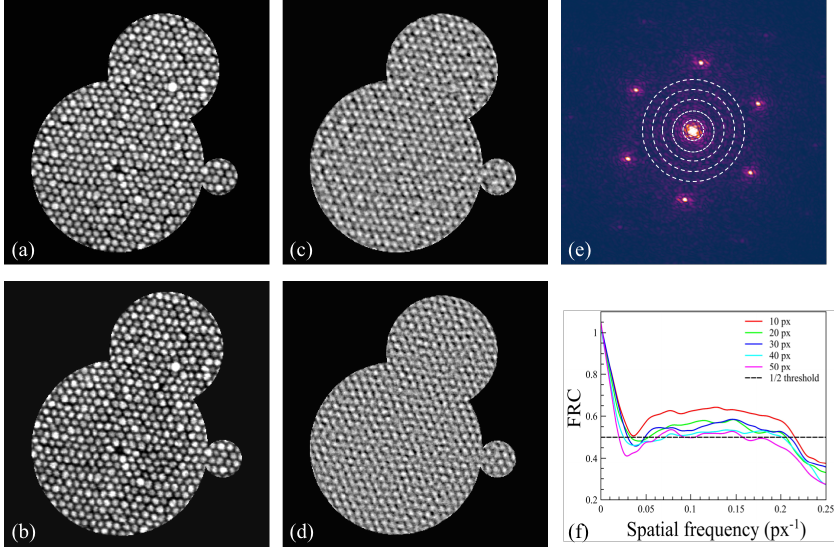
Figure 1. Numerical investigation of the robustness of the hybrid input–output (HIO) algorithm: ( a ) original image; reconstructions obtained from the square root of the modulus of the Fourier transform of the original image when central area with radius ( b ) R = 0; ( c ) R = 20; ( d ) R = 50 pixels (px) were removed. ( e ) Fourier transform of the original image (a); dashed white lines indicate the beamstop area. ( f ) Fourier ring correlation (FRC) analysis of the reconstructed